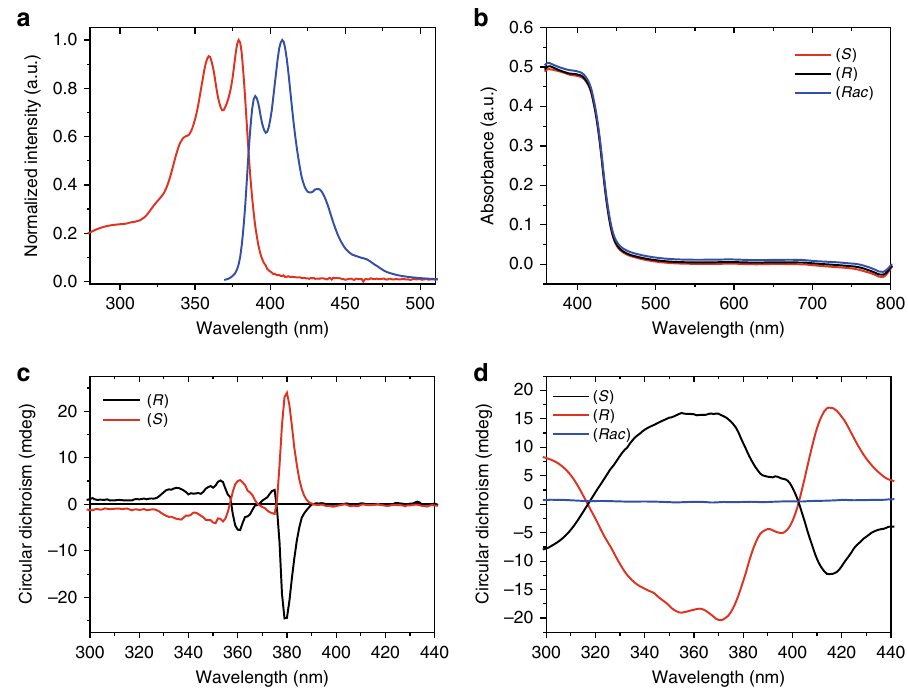
Fig. 2 UV – Vis spectra, PL spectra, and CD spectra of H 2 AlaNDI ligands and AlaNDI-Zn SBCPs. a Absorption and emission spectra of H 2 AlaNDI in dichloromethane (1 × 10 – 4 M). b UV – Vis spectra of homochiral and heterochiral AlaNDI-Zn SBCPs on a quartz plate. c , d CD spectra of c H 2 AlaNDI solutions in dichloromethane (1 × 10 – 4 M) and d homochiral and heterochiral AlaNDI-Zn SBCPs in ethanol